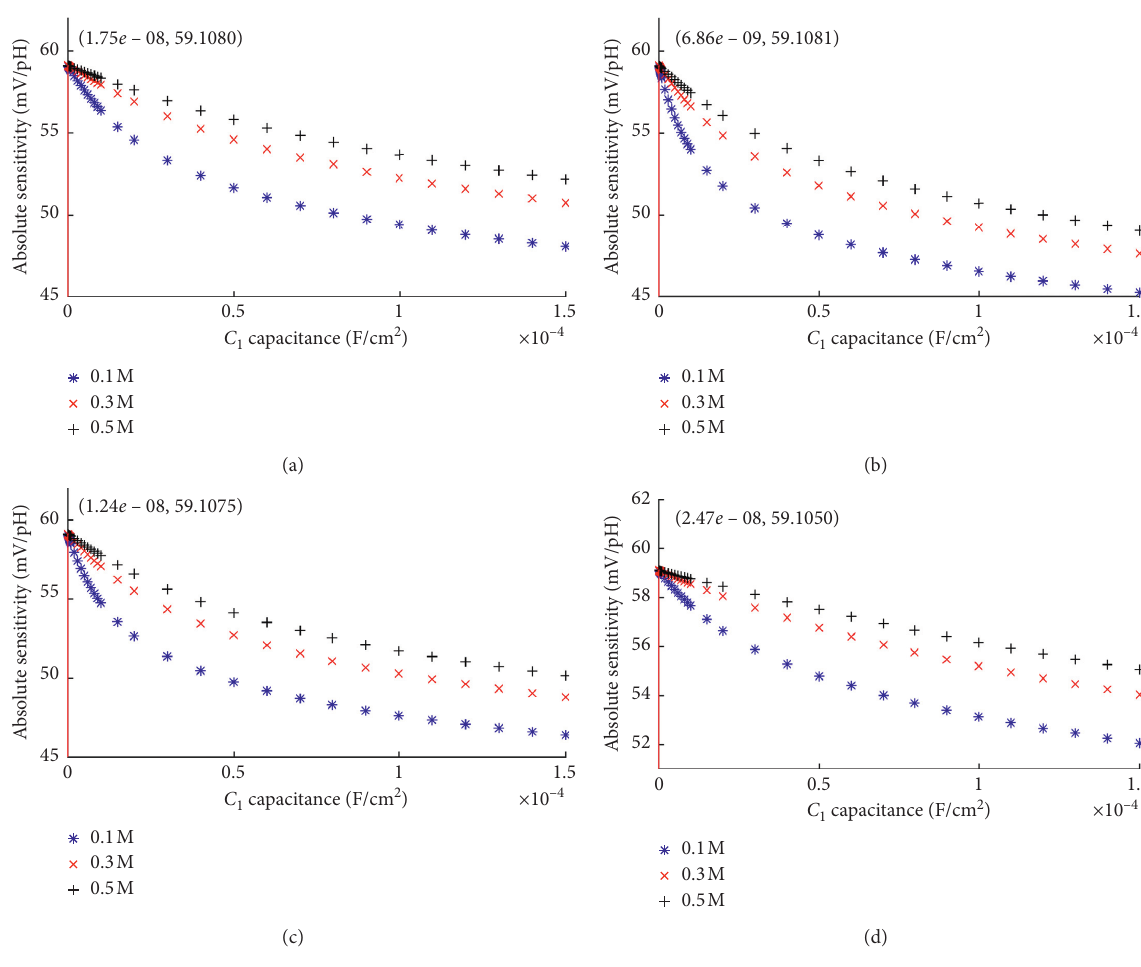
Figure 4: Absolute sensitivity against C 1 capacitance for (a) TiO 2 , N s : 12.5, ε s : 35, (b) Ta 2 O 5 , N s : 10, ε s : 25, (c) Ta 2 O 5 , N s : 12, ε s : 25, and (d) Al 2 O 3 , N s : 12.04, ε s : 10.43. The electrolyte is KCl for all cases. Table 3: Summary of C 1 capacitance variation model